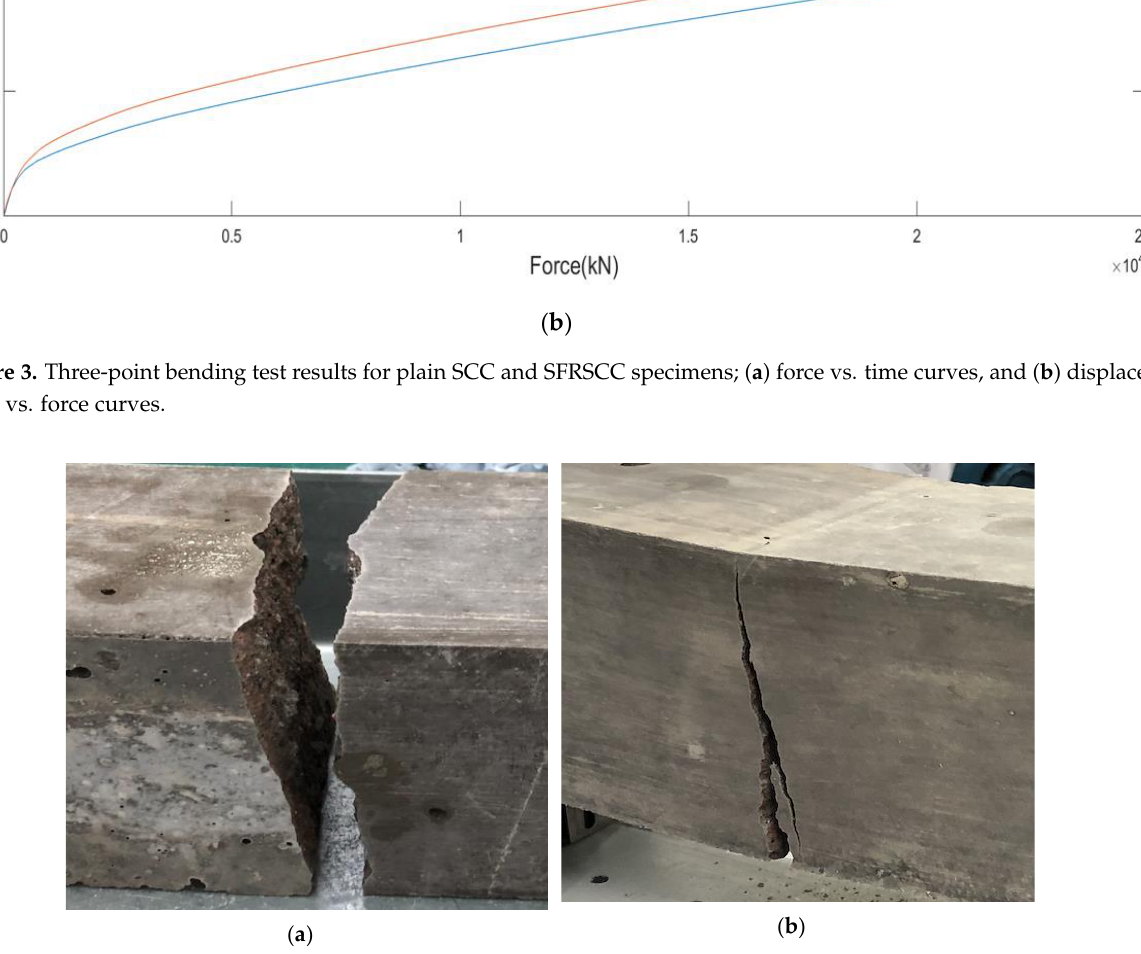
Figure 4. Modes of failure for: ( a ) plain SCC beam, ( b ) SFRSCC beam.